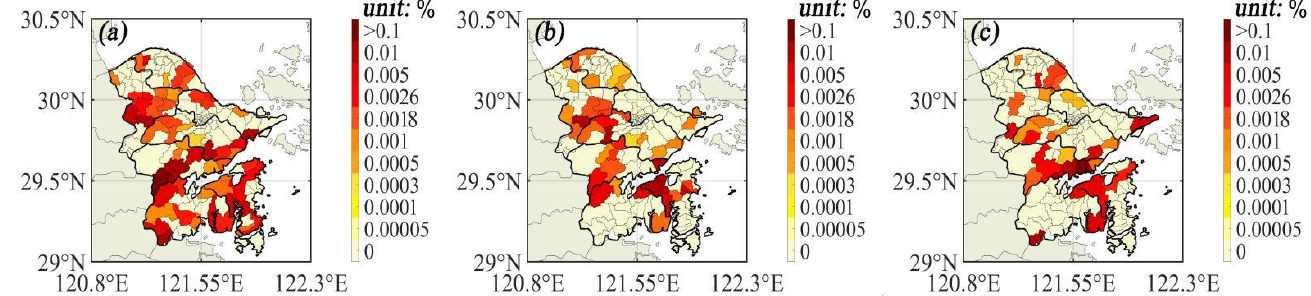
Figure 7. Insured loss rate of townships due to type II typhoons. ( a ) 1410 Matmo; ( b ) 1614 Meranti; ( c ) 1808 Maria.